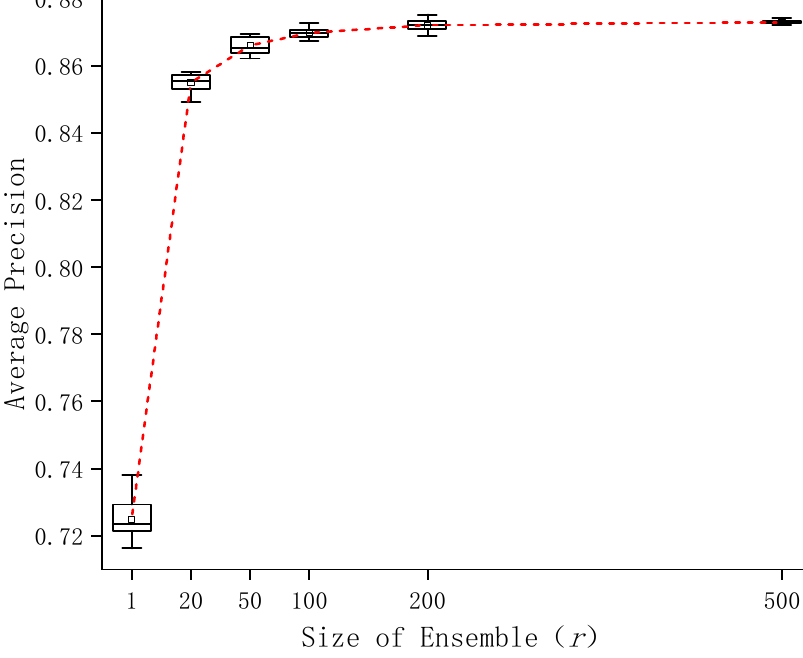
Figure 5. Average accuracy and training time of RSFCF over Small60 datasets under different set- tings of parameter a.